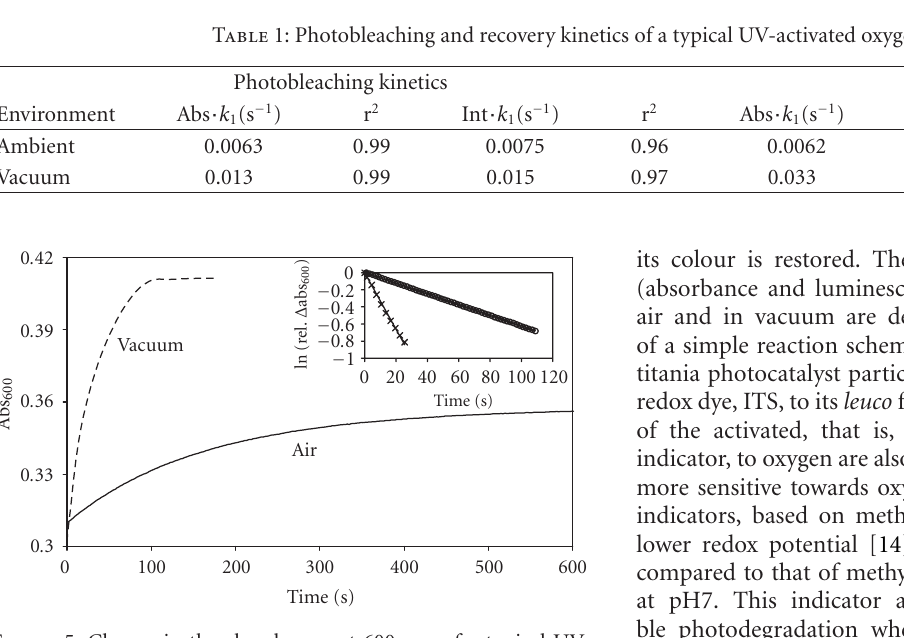
Figure 5: Change in the absorbance, at 600nm, of a typical UV- activated ITS oxygen indicator film as a function of time, under an ambient atmosphere (solid line) and an ITS film UV-activated under vacuum and subsequently exposed to air (broken line). Each film was fully photobleached, using UVA light, before being allowed to recover. The insert diagram is a first-order plot (natural log of the change in the absorbance, that is, ln ( Δ Abs), at 600 nm versus time), over one half life, derived from the data in the main diagram. The rate constants for this recovery step are given in Table 1.